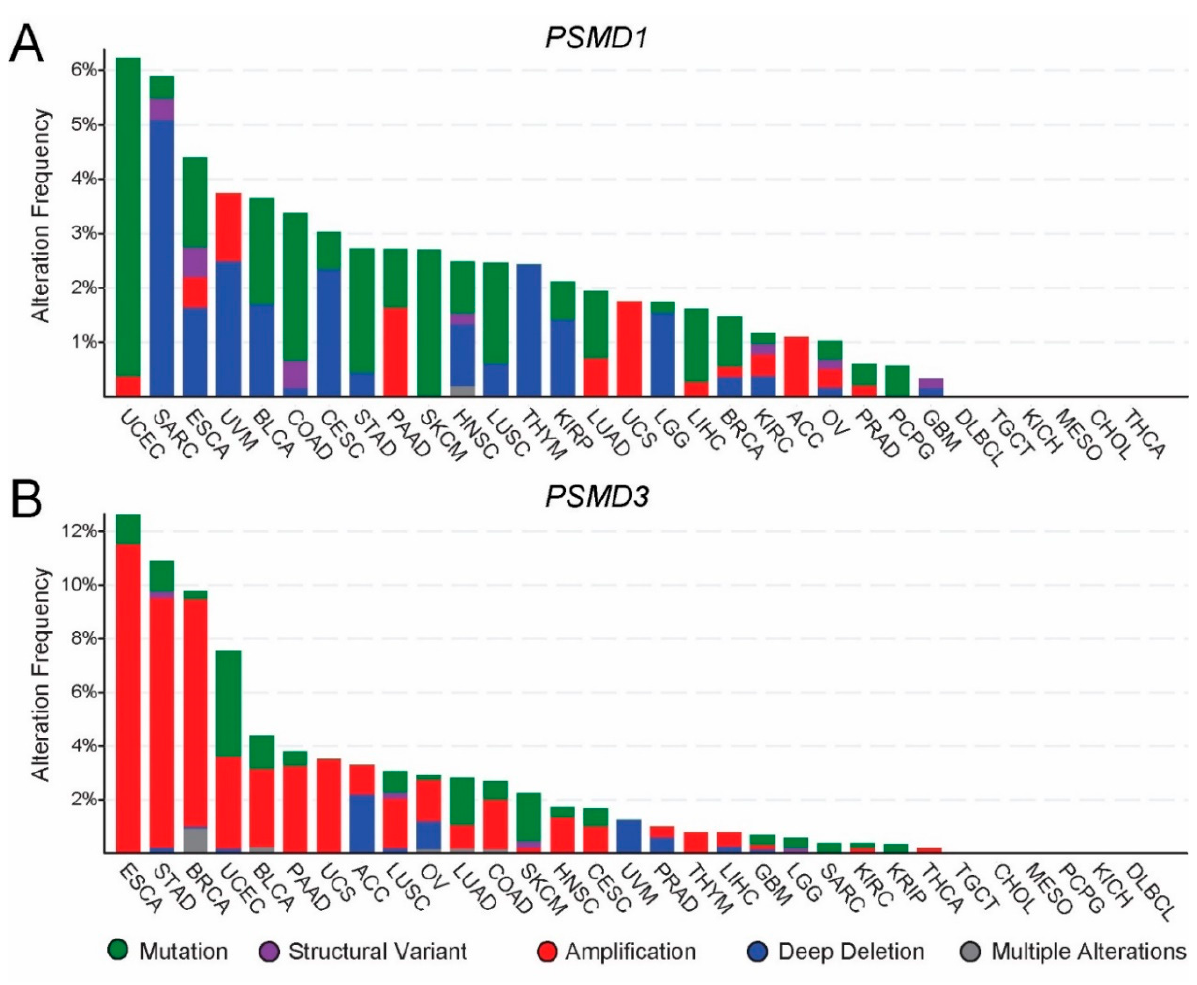
Figure 3. Genomic alterations in the genes encoding PSMD1 and PSMD3 in multiple human cancers. Using data from cBioPortal, we analyzed genomic alterations associated with the PSMD1 ( A ) and PSMD3 ( B ) genes in multiple TCGA cancers. The PSMD1 gene was primarily associated with mutations or deep deletions, whereas the PSMD3 gene showed mostly amplifications. ACC, adrenocortical carcinoma; BLCA, bladder urothelial carcinoma; BRCA, breast invasive carcinoma; CESC, cervical squamous cell carcinoma and endocervical adenocarcinoma; CHOL, cholangiocarcinoma; COAD, colon adenocarcinoma; DLBCL, lymphoid neoplasm diffuse large B-cell lymphoma; ESCA, esophageal carcinoma; GBM, glioblastoma multiforme; HNSC, head and neck squamous cell carcinoma; KICH, kidney chromophobe; KIRC, kidney renal clear cell carcinoma; KIRP, kidney renal papillary cell carcinoma; LGG, Brain lower grade glioma; LIHC, liver hepatocellular carcinoma; LUAD, lung adenocarcinoma; LUSC, lung squamous cell carcinoma; MESO, mesothelioma; OV, ovarian serous cystadenocarcinoma; PAAD, pancreatic adenocarcinoma; PRAD, prostate adenocarcinoma; PCPG, pheochromocytoma and paraganglioma; READ, rectum adenocarcinoma; SARC, sarcoma; SKCM, skin cutaneous melanoma; TGCT, testicular germ cell tumors; THCA, thyroid carcinoma; THYM, thymoma; STAD, stomach adenocarcinoma; UCEC, uterine